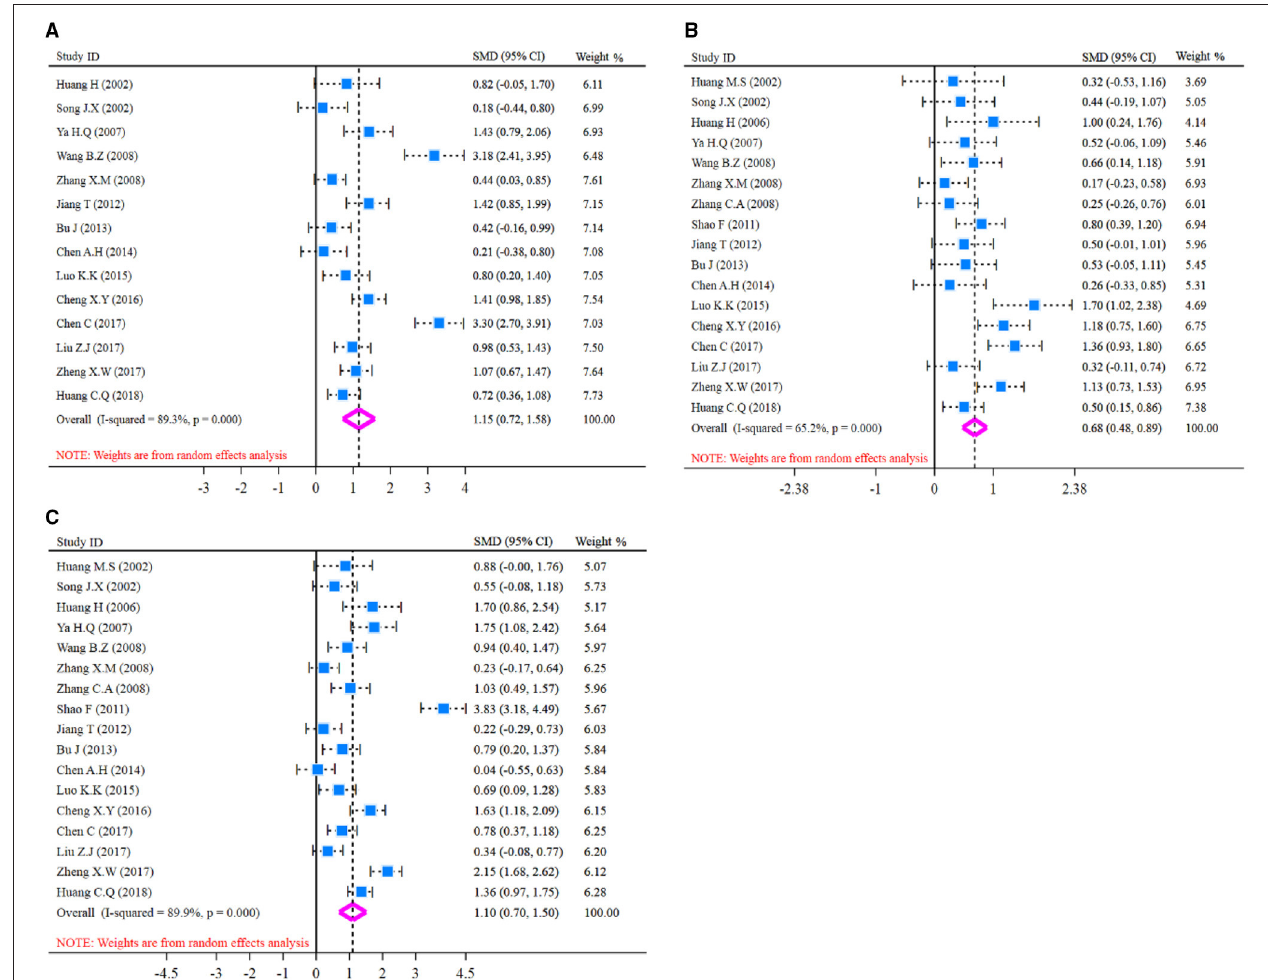
FIGURE 3 | Forest plot of standard mean difference (SMD) for IgA, IgM, and IgG. (A) Forest plot of IgA; (B) Forest plot of IgM; (C) Forest plot of IgG. All pooled analysis applied a random effect